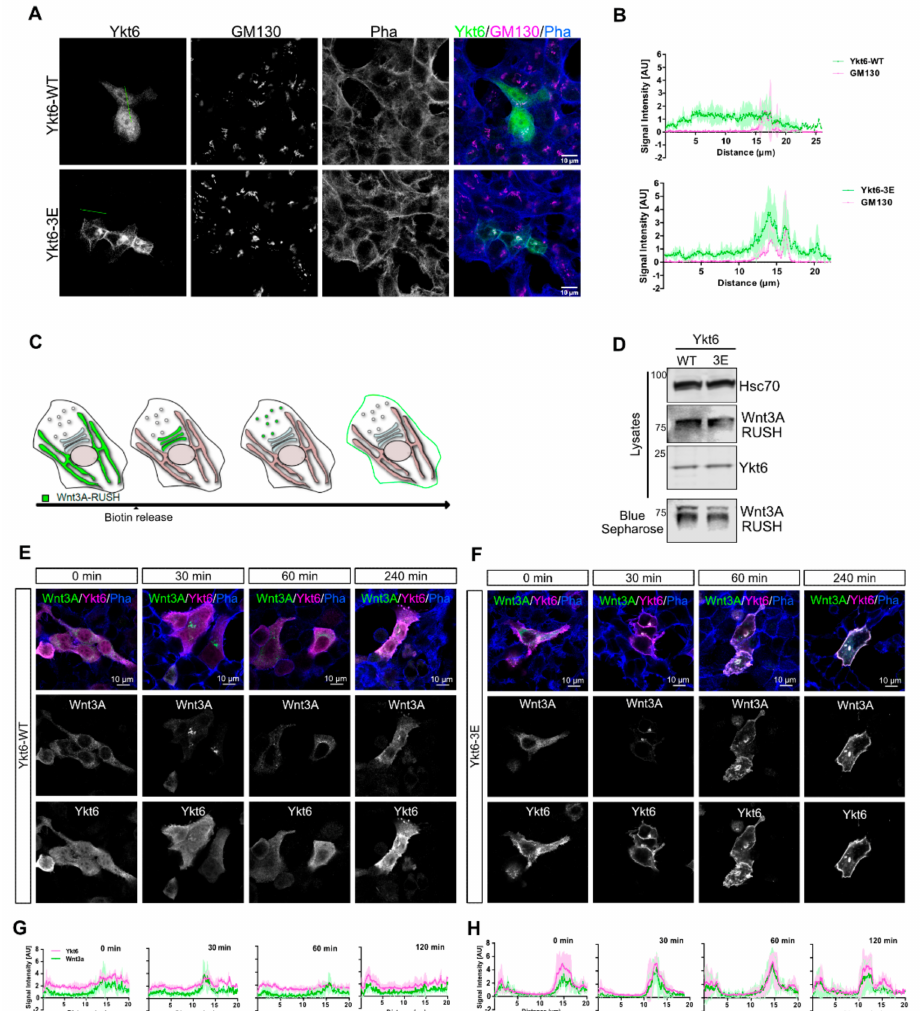
Figure 2. Phosphomimicking mutations accumulate Ykt6 at membranes in the secretory pathway. ( A ) Representative immunofluorescence and ( B ) Quantification of Ykt6-WT and -3E transfected in HCT116 cells and additionally stained for GM130, Phalloidin, and Hoechst. Scale bar 10 µ m. ( C ) Scheme representation of Wnt3A-RUSH (“retention using selective hook”) system. ( D ) Representative immunoblot of Wnt3A, Ykt6 WT, and -3E in Hek293T lysates and blue sepharose precipitation of Wnt3A secretion from the supernatant after 24 h of biotin treatment. ( E ) HCT116 cells transfected with RUSH-EGFP-Wnt3A in combination with Ykt6-WT and quantification in ( G ). ( F ) Ykt6-3E stained for Ykt6 and F-actin in addition to GFP and quantification in ( H ). Scale bar represents 10 µ m, representative images, and quantifications of three independent